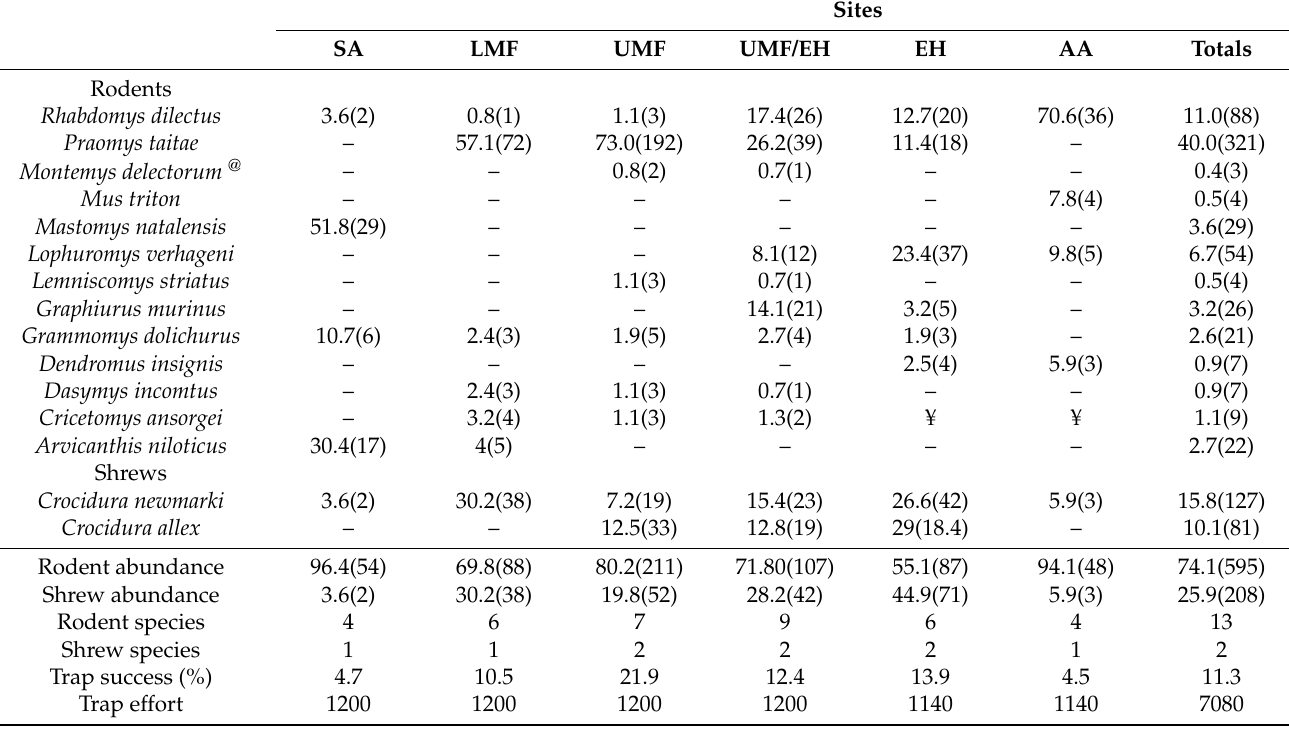
Table 1. Percentage contribution and total abundance (in parentheses) of small mammals in different sites on Mount